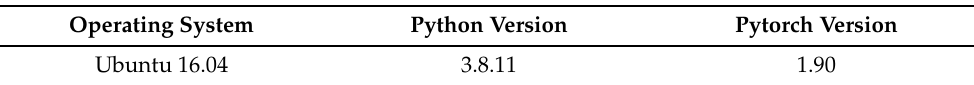
Table 3. Software used for network